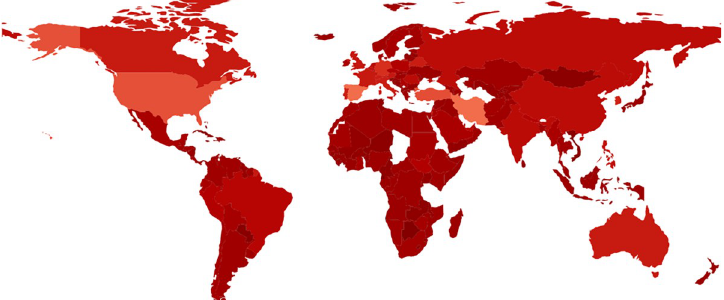
Fig 4. The estimated basic reproduction number R 0 of COVID-19 in different countries. Eq (2) estimates the basic reproduction number R 0 as an increasing function the exponential growth rate r . On one hand, Fig 3 shows the initial exponential growth rate r ; on the other, Fig 4 shows the corresponding basic reproduction number R 0 . Fig 4 colors countries by darkening linearly from lightest red ( R 0 = 5.35 for Spain ESP) down to darkest red ( R 0 = 0.17 for Equatorial Guinea GNQ). Python GeoPandas generated Fig 4.